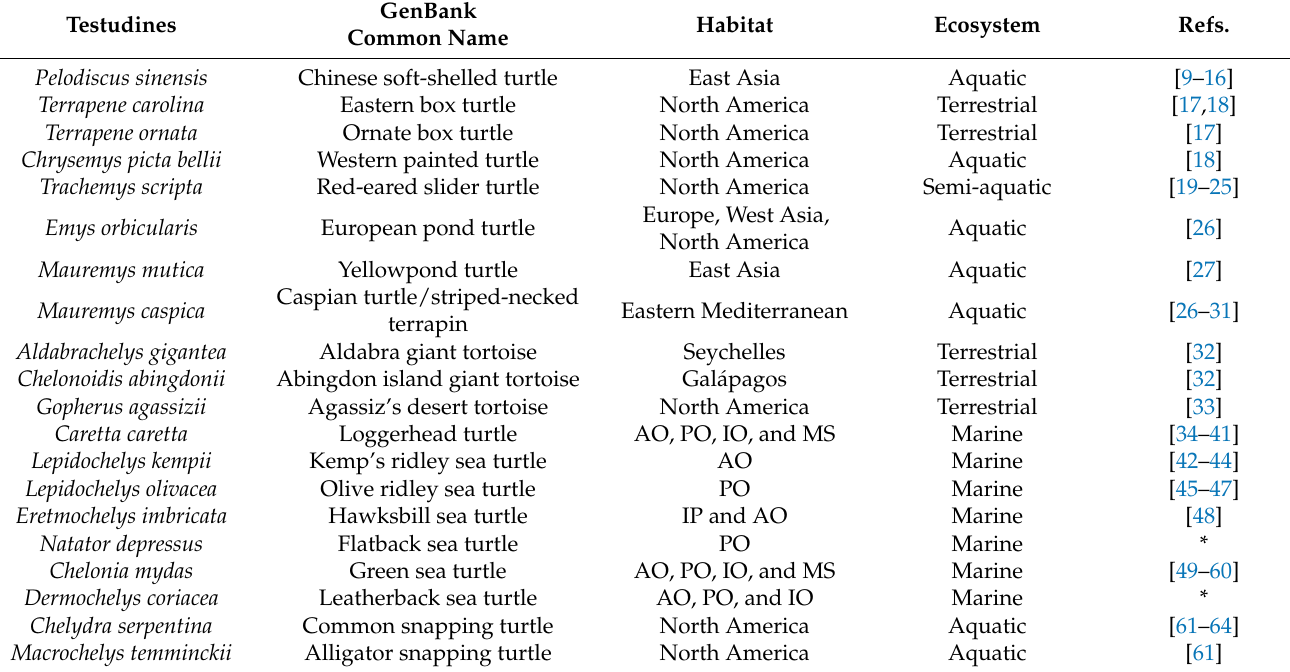
Table 1. Overview of Testudines habitat, ecosystem, and immune system studies